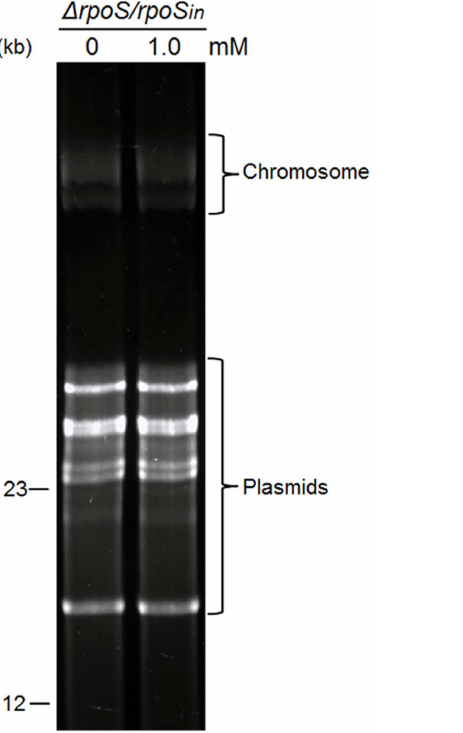
Figure 6. Genomic DNA remains intact in induced cell death. The transformant D rpoS/rpoS in was grown to early log phase (10 7 cells/ ml) before IPTG was added to a final concentration of 1.0 mM and induced for 2 days. Spirochetes not receiving IPTG were used as the control. Total DNA was extracted and analyzed by electrophoresis. Two DNA markers (12 and 23 kb) are labeled on the left.